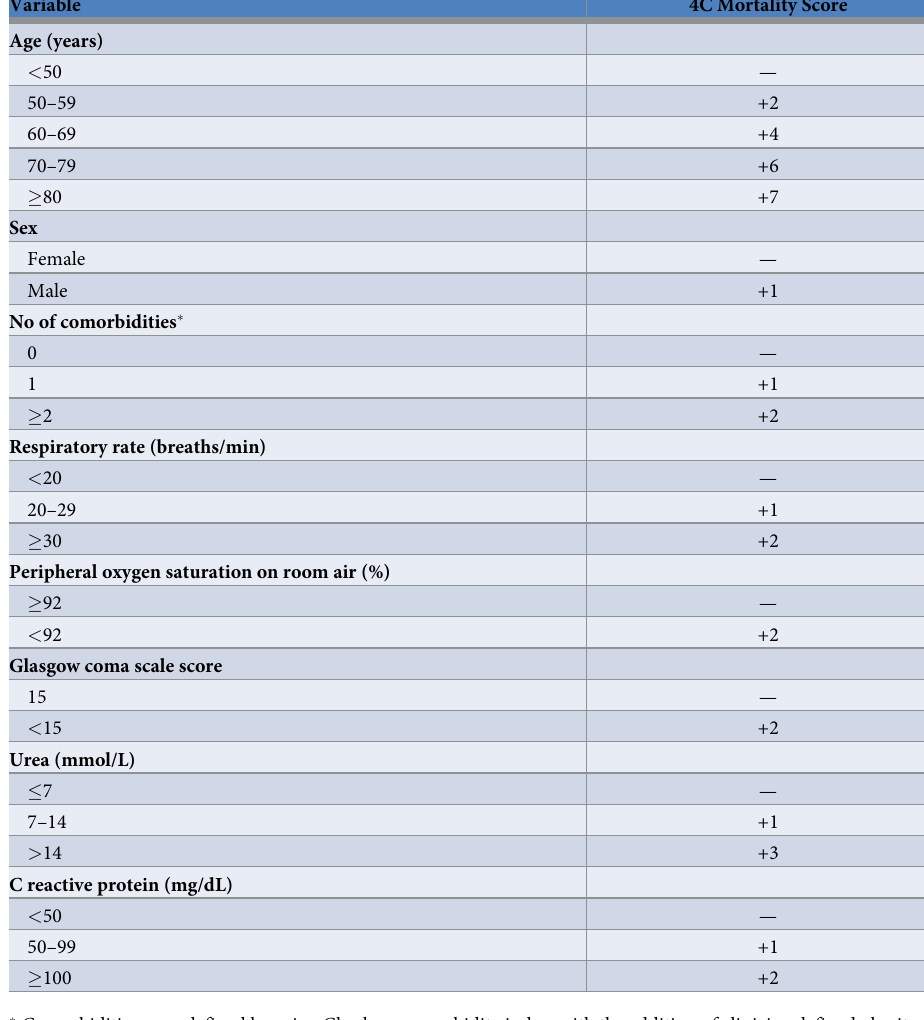
Table 1. Final 4C mortality score for in-hospital mortality in patients with COVID-19. Prognostic index derived from penalised logistic regression (LASSO) model [6].